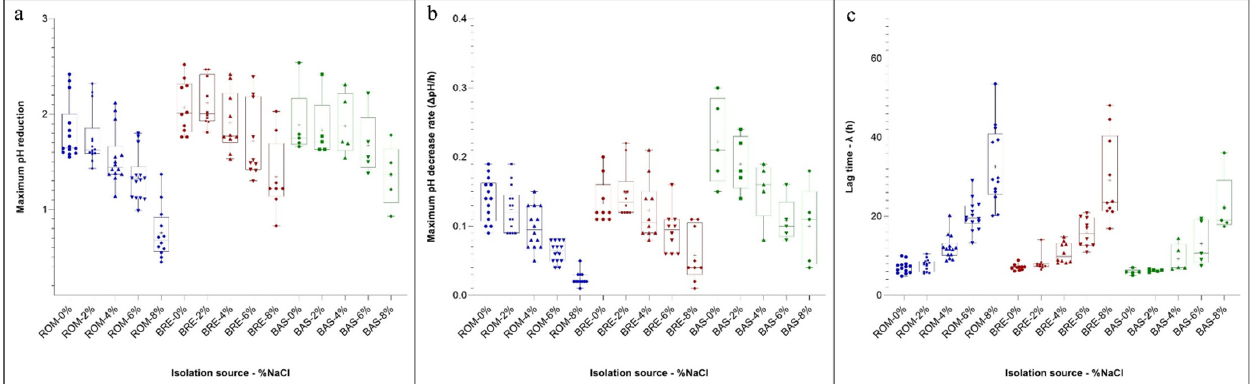
Figure 2. Box and whiskers plots of the parameter estimated for the Gompertz equation of the pH drop curves of strains in relation to the isolation source and NaCl concentration. Boxes represent the limit of the 25th and 75th percentile of the distribution, the line inside the boxes represents the median and the whiskers represent the minimum and maximum values. ( a ) Maximum pH reduction estimates; ( b ) Maximum pH decrease rate estimates ( ∆ pH/h); ( c ) lag (h) to detect a measurable pH drop. Blue = Salame Romagnolo, Red = Salame Bresciano, Green = Salame